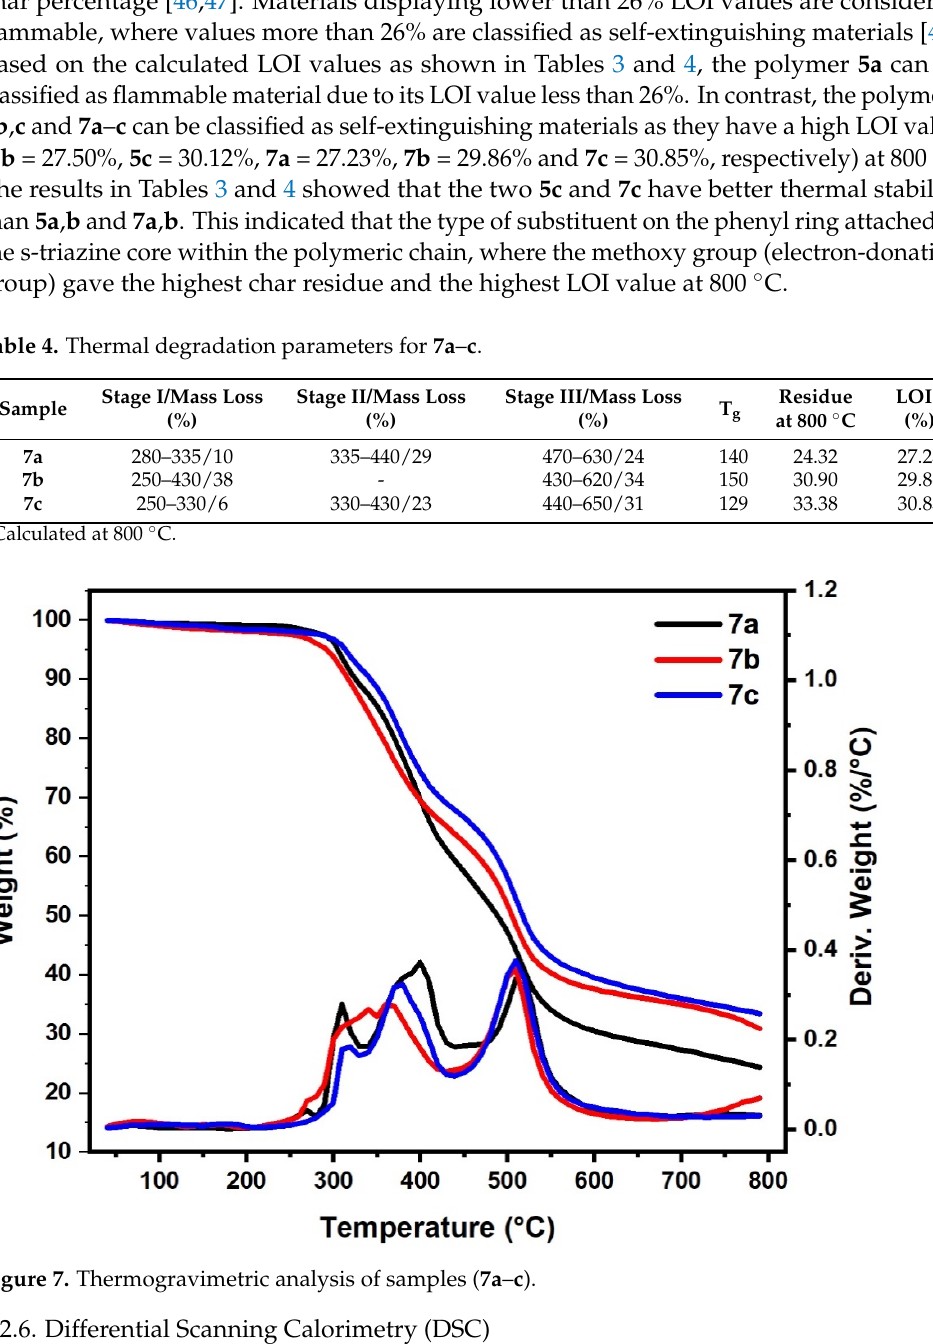
Table 4. Thermal degradation parameters for 7a-c.